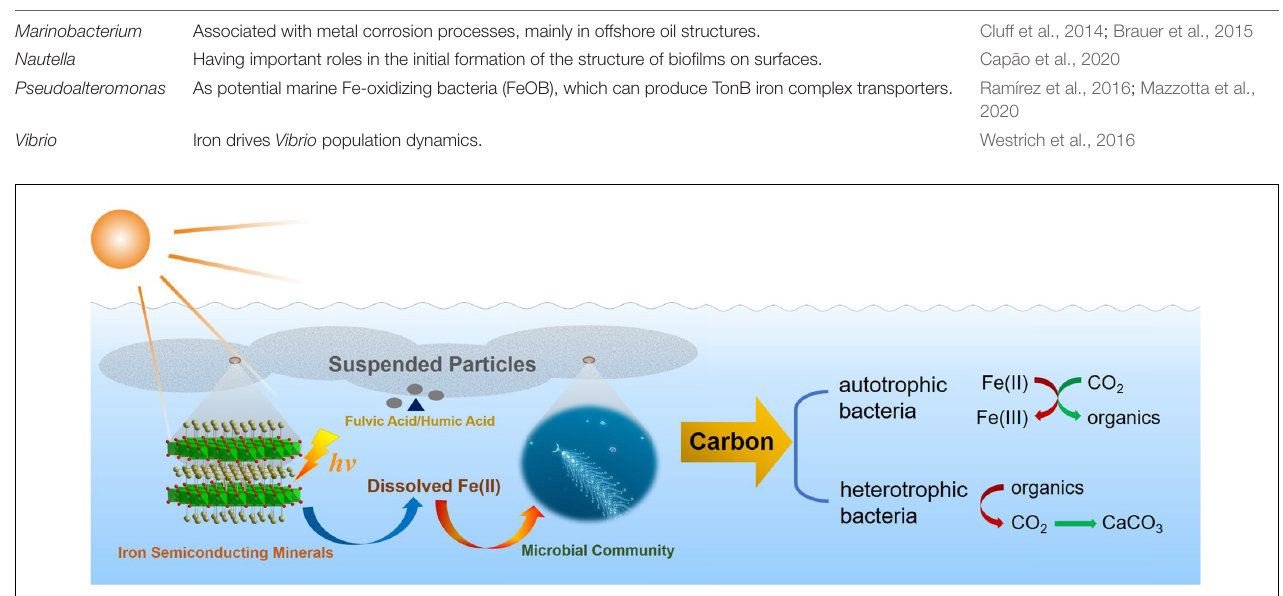
TABLE 2 | Dominant microbial genera in alphabetical order and references associated with iron. Genus